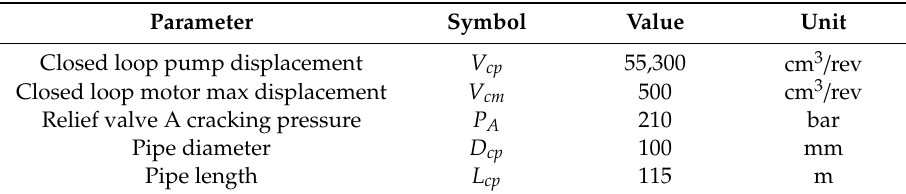
Figure 10. The first input step signal.